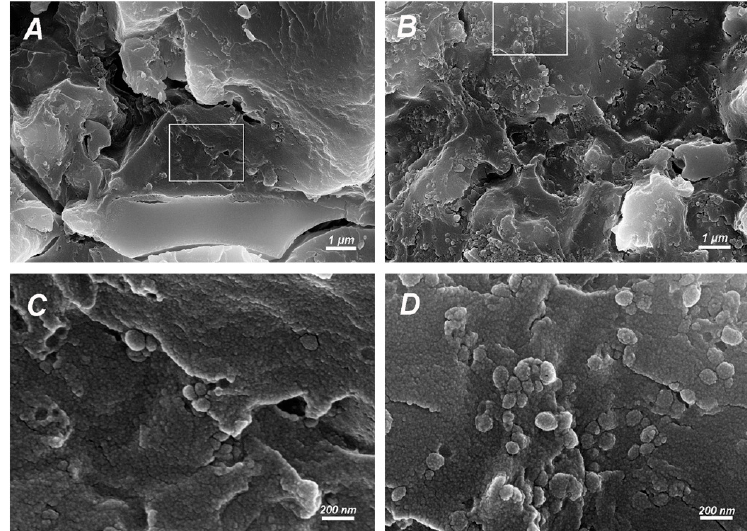
Figure A1. FESEM images of fracture surfaces from ( A ) 1% CHX@pMSN; and ( B ) 5% CHX@pMSN groups. ( C , D ) are magnified pictures of rectangles in ( A , B ) respectively. The nanoparticles dispersed uniformly in the GIC matrix and formed small agglomeration in 1% CHX@pMSN group. The